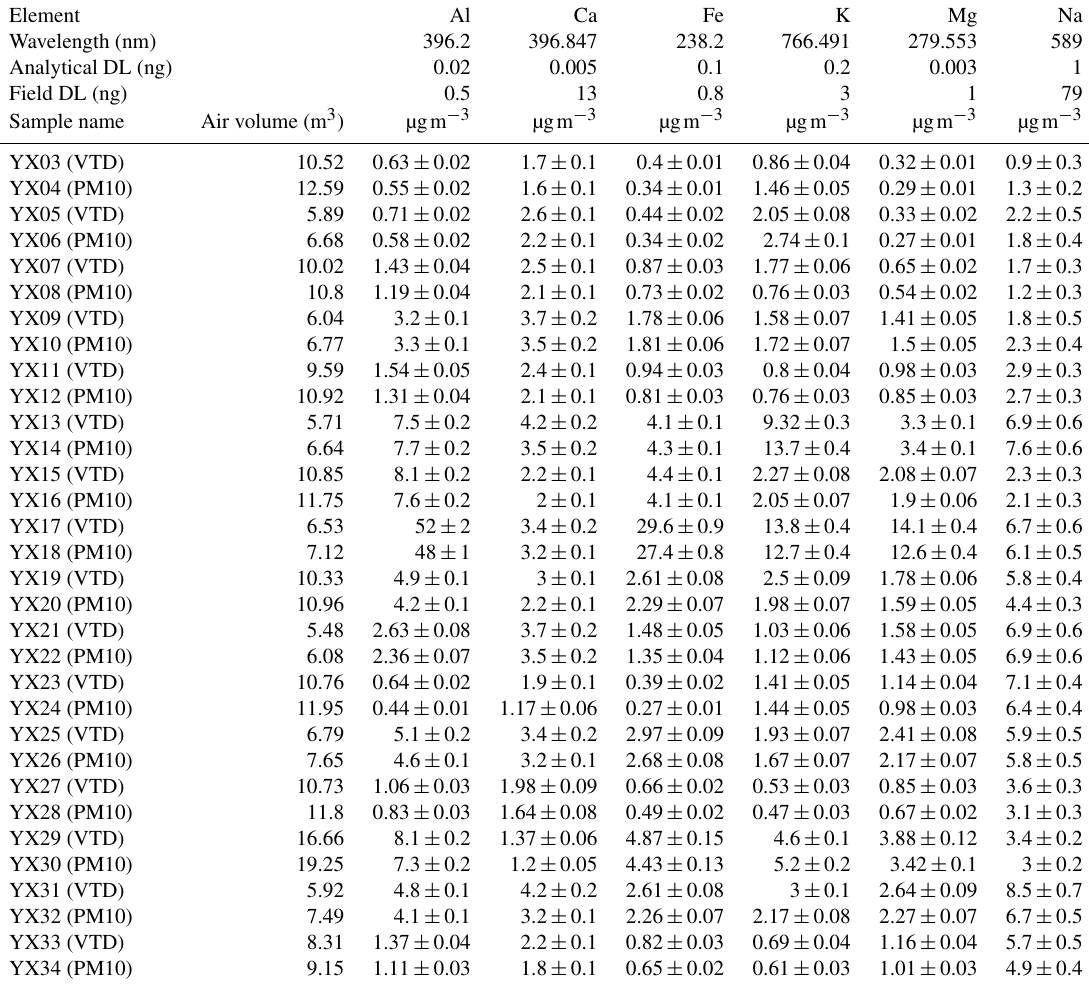
Table A1. Elemental air concentrations measured with ICP-AES. Element